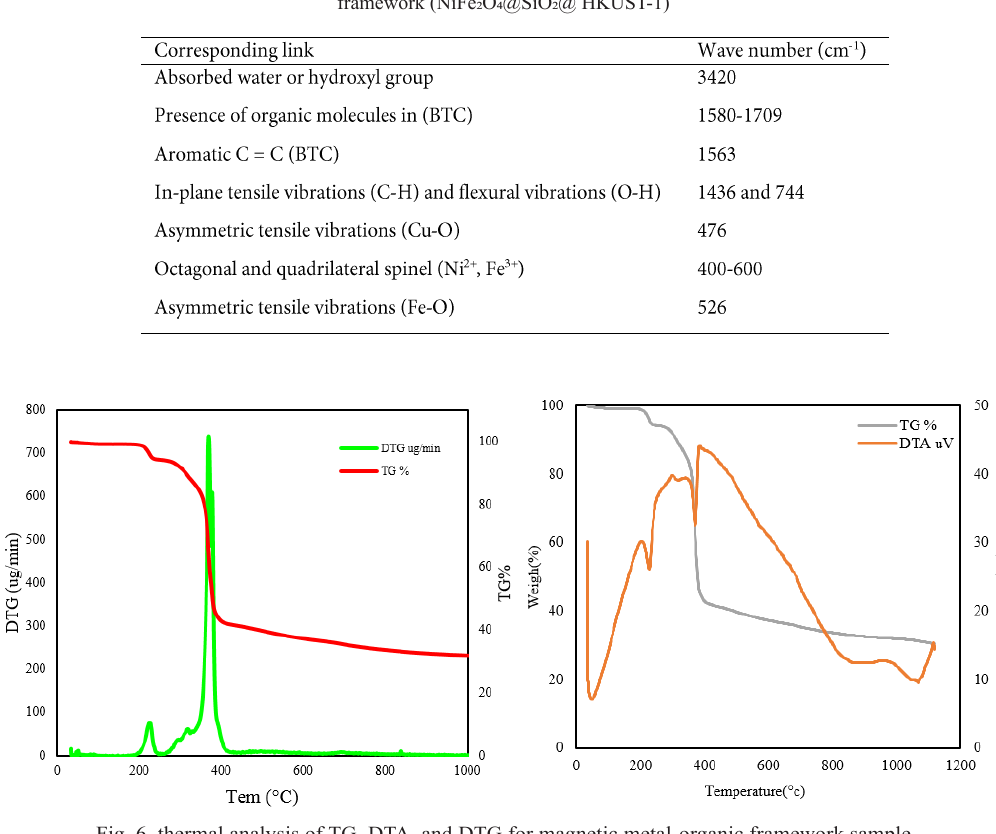
Table 3: Corresponding peaks and bonds in the FTIR spectrum of a nanocomposite sample of a magnetic